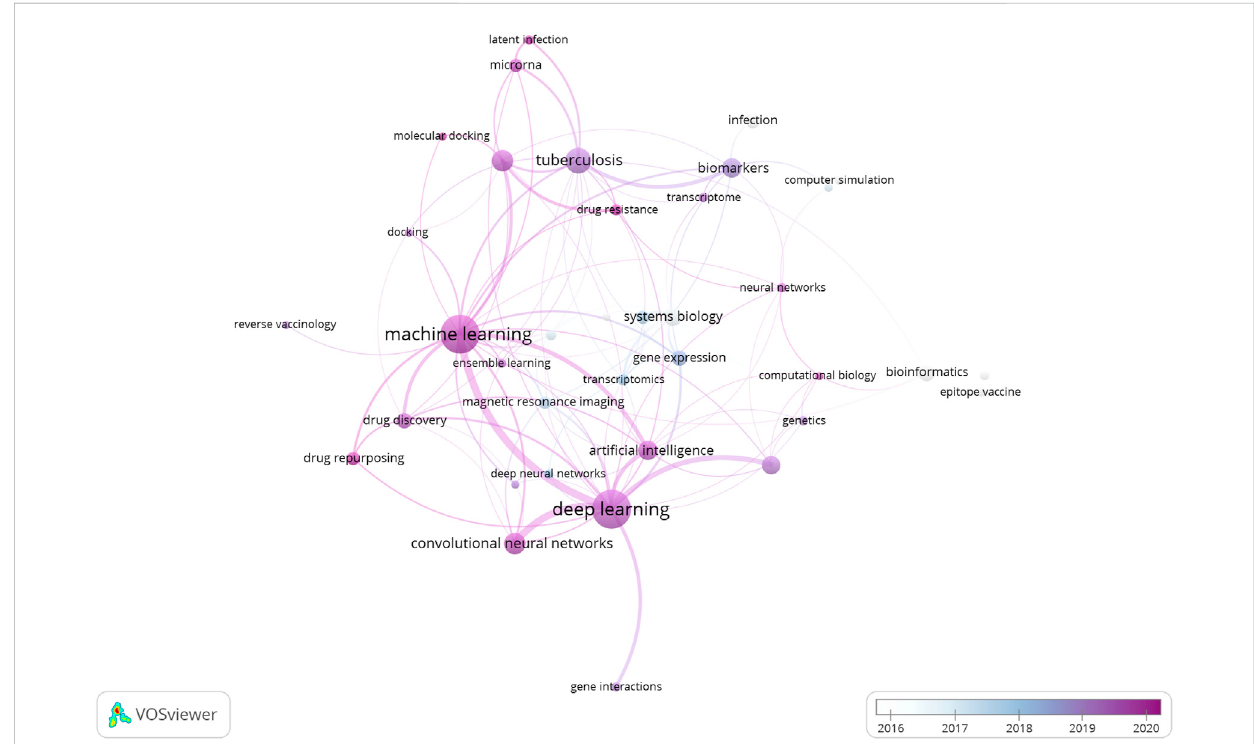
FIGURE 4 Network of representative keywords retrieved from theresearch papers included inthe review article. The network clearly indicates the dominance of Machine Learning and Deep Learning algorithms in the research and development domain linked with